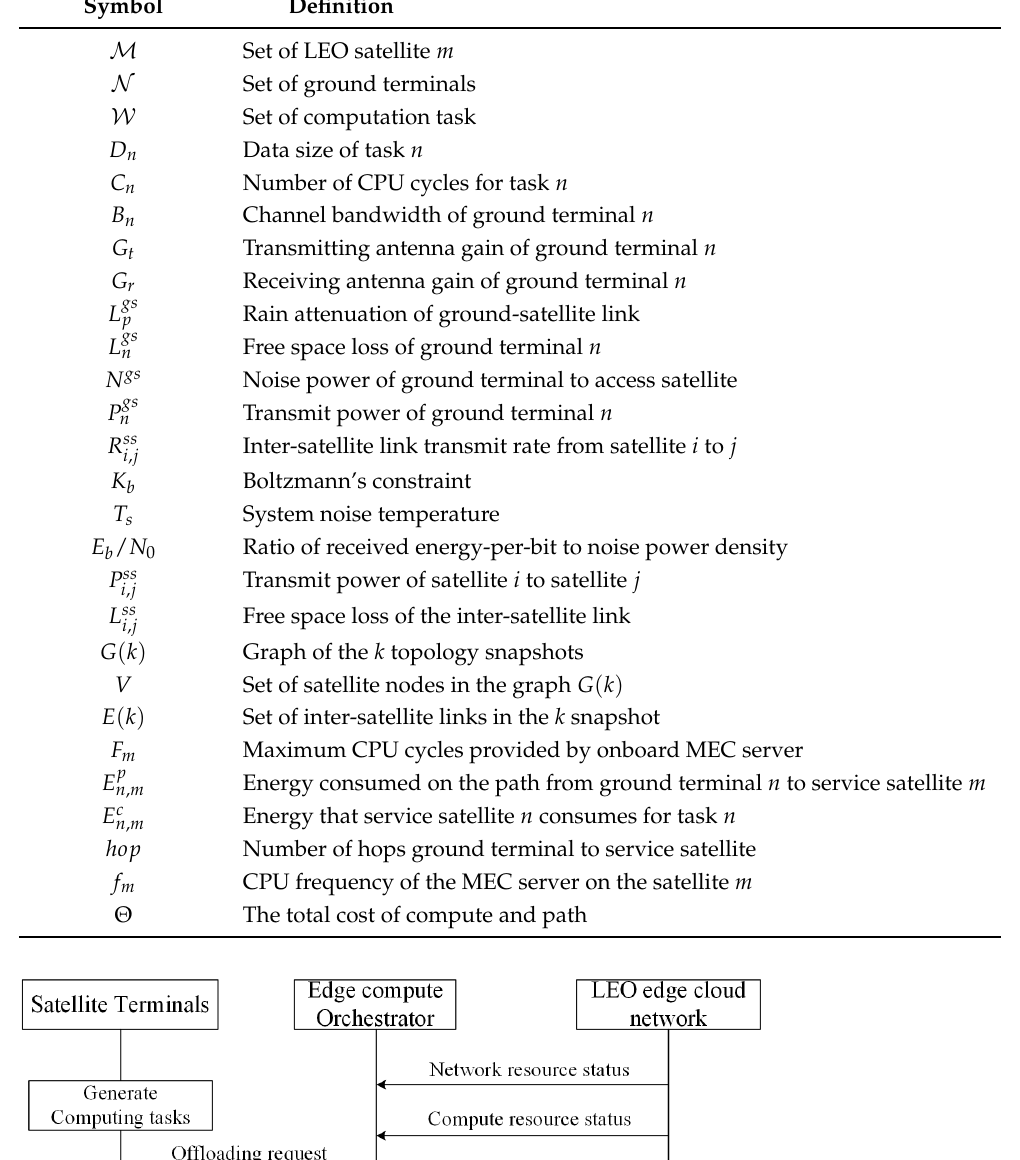
Table 2. Notation definitions.